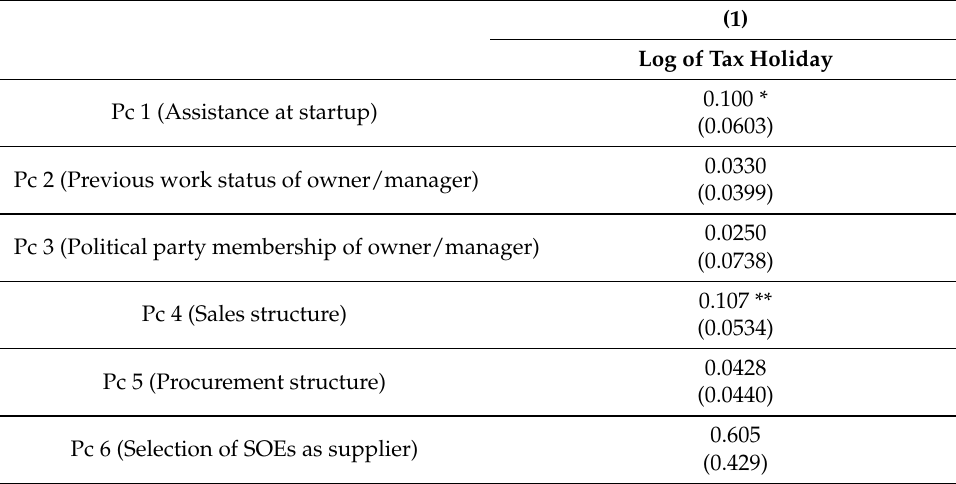
Table 9. Effects of Political Connections (seven proxies) on Tax Holiday